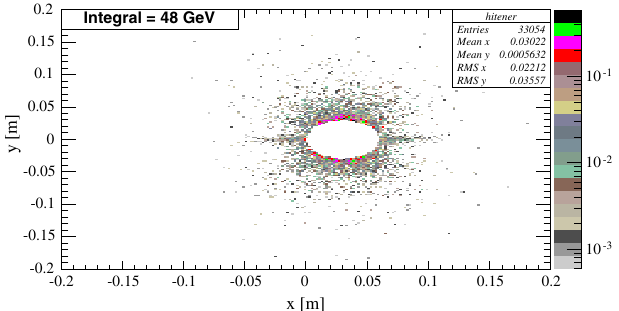
FIG. 20. Spatial distribution of energy deposited by the tertiary photons at a transverse plane 3 m from the IP. Only photons with production angles above 20 mrad are displayed